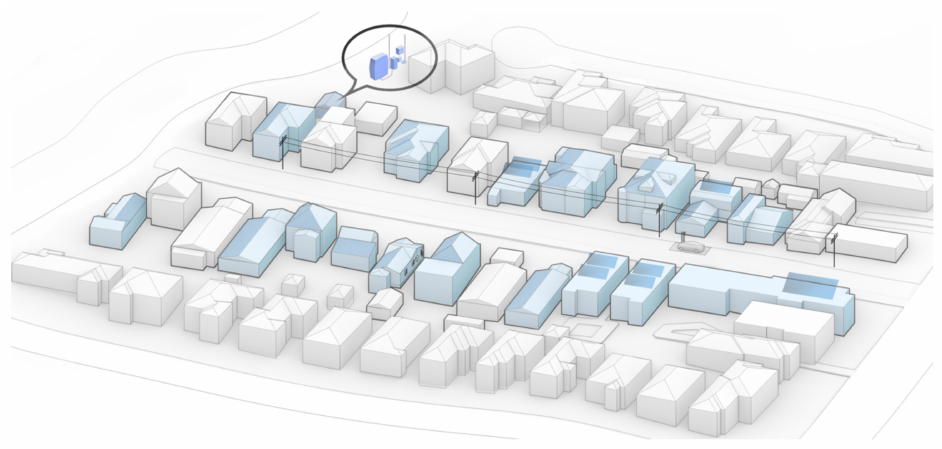
Figure 8. Community microgrid in an existing neighborhood setting (retrofit) (source: California Institute for Energy and Environment, UC Berkeley EcoBlock).